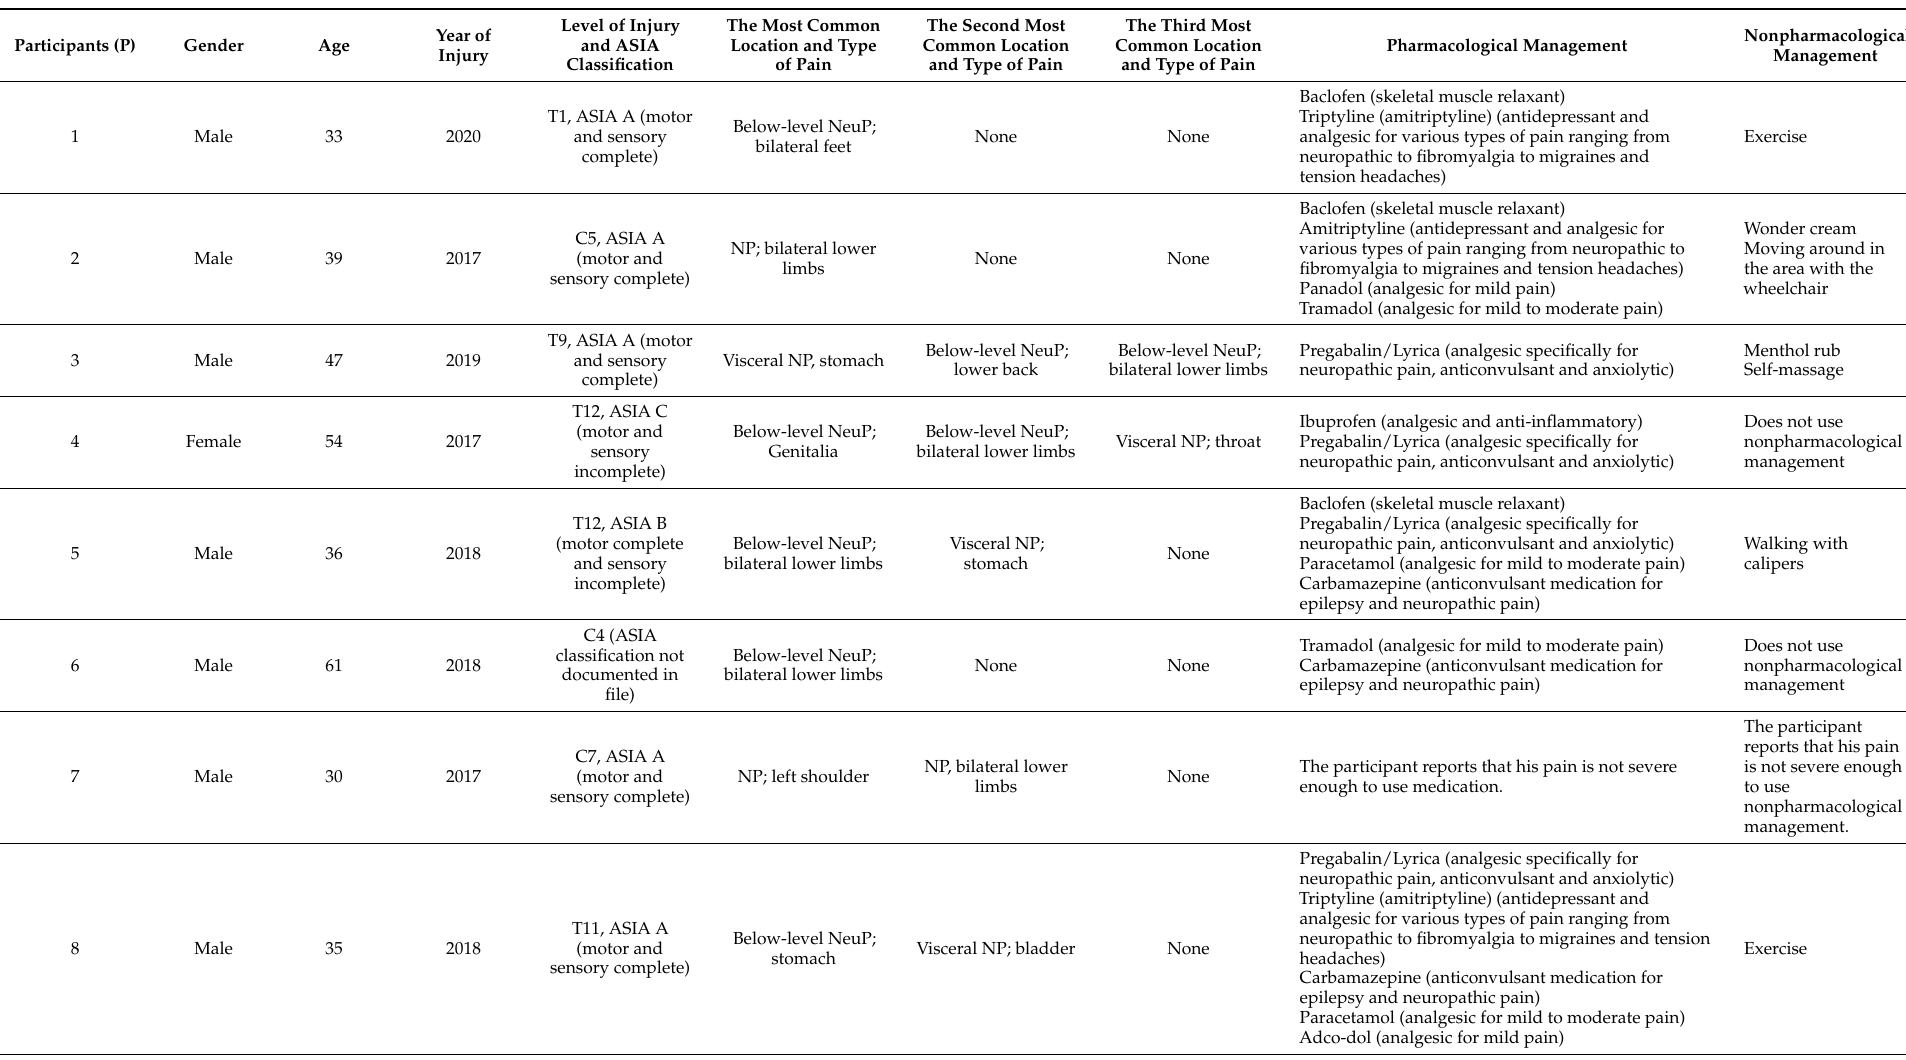
Table 1. Description of participants, their pain and pharmacological